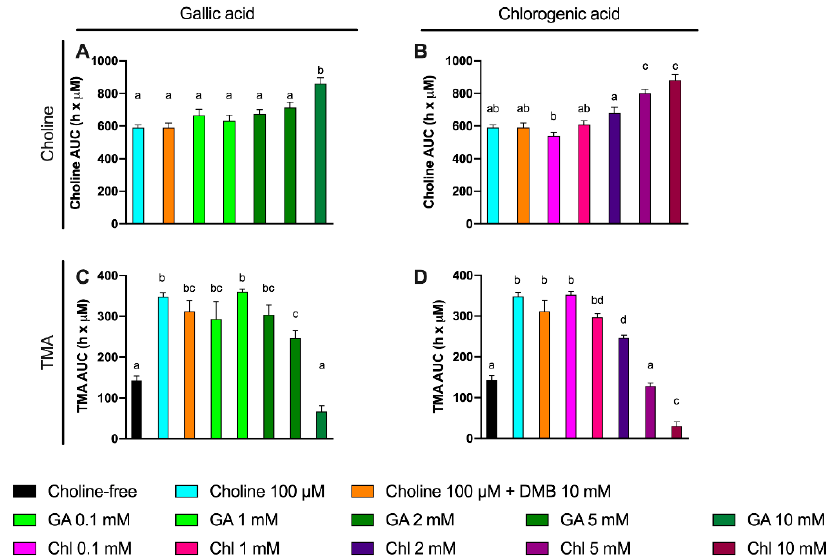
Figure 8. Area under the curve (AUC) of choline ( A , B ) and TMA ( C , D ) kinetic curves obtained at optimal fermenting conditions (fecal slurry 20% and choline 100 µM) supplemented with gallic acid or chlorogenic acid (0.1–10 mM). For choline AUCs, time-matched choline concentrations in the background (0 µM choline) are subtracted from choline-supplemented conditions. Results are expressed as mean (h × µM of choline or TMA) ± SEM ( n = 6). Different letters indicate statistical differences ( p < 0.05) by one-way ANOVA (Tukey’s post hoc test). Abbreviations: TMA, trimethylamine; GA, gallic acid; and Chl, chlorogenic acid. TMA levels at 0 µM choline were not detected, and thus, have not been included for clarity.